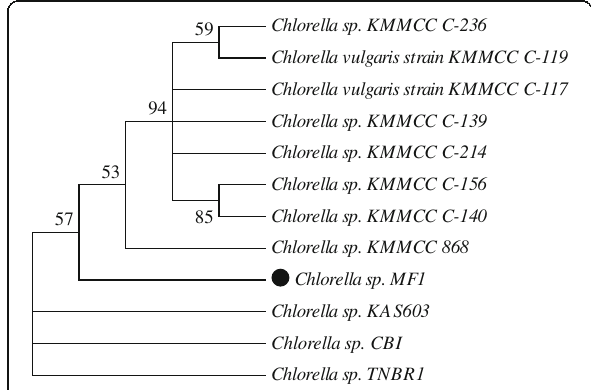
Fig. 3 Maximum likelihood (ML) phylogenetic tree of Chlorella sp. MF1 based on partial sequencing of 18S rRNA. The cutoff value adopted is 50%. Bootstrap values were calculated from 1000 permutations. The formation of parallel branches is due to the similarity of